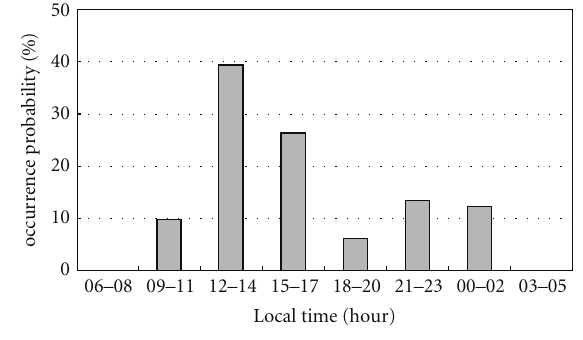
Figure 16: Local time dependence of the occurrence probability of the ionization ledge based on the ISIS-2 data analysis (from Uemoto et al. [50]).